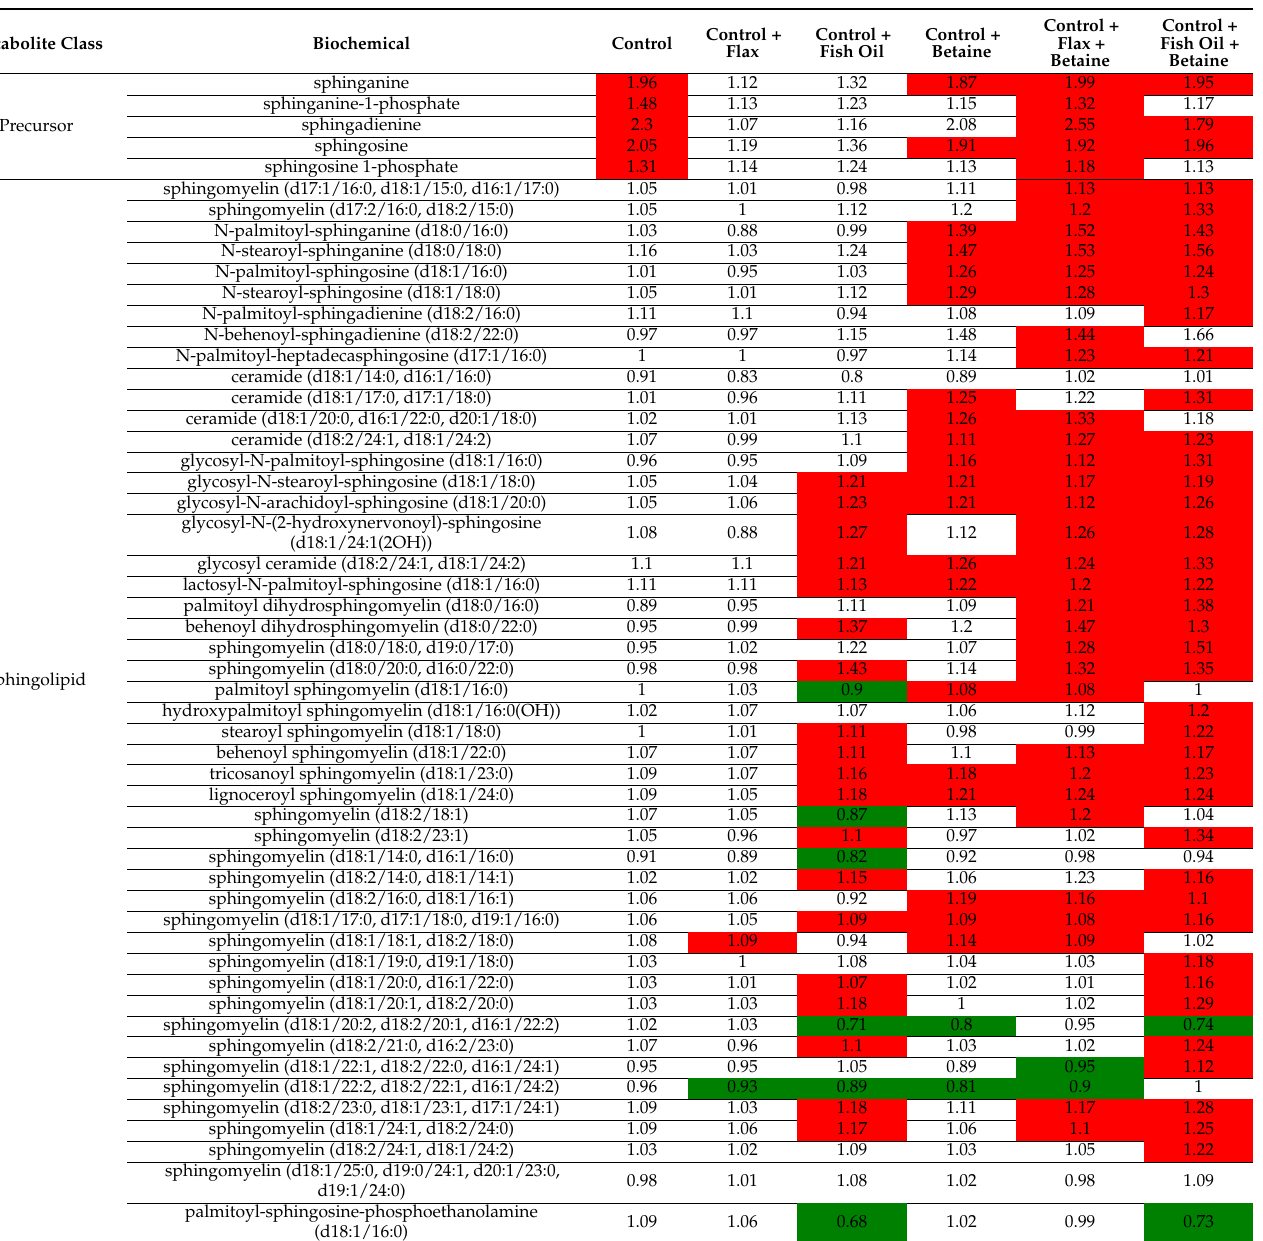
Table 10. Sphingolipids which changed during the study while consuming control, or betaine, flax, and fish oil supplemented foods